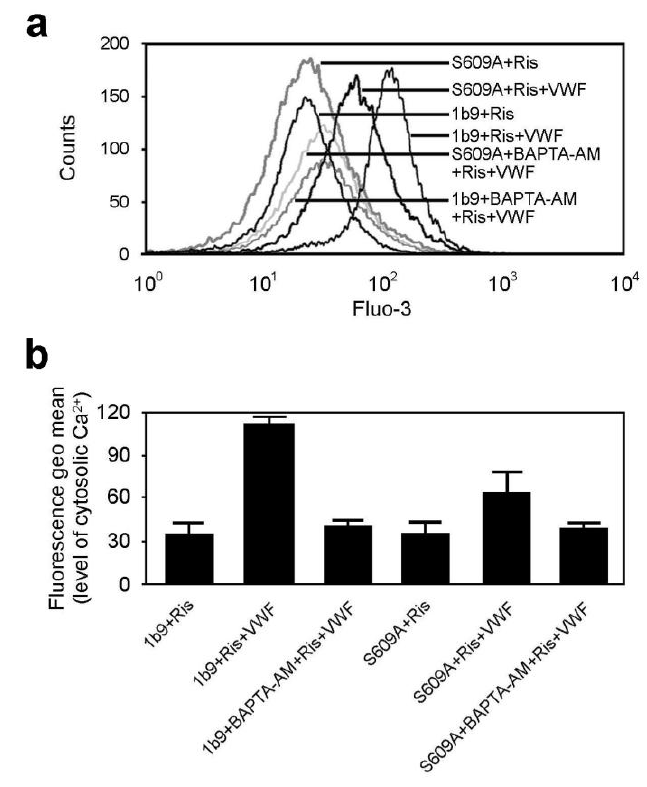
Figure 4. The S609A mutation inhibits elevation of intracellular Ca 2+ . ( a , b ) 1b9 or S609A cells were incubated with 8 μM Fluo-3/AM for 30 min at 37 °C in the dark. The external Ca 2+ was adjusted to 1 mM, and then cells were stimulated by ristocetin in the presence or absence of VWF for 10 min at RT, and analyzed by flow cytometry. The Fluo-3/AM-loaded cells were also pre-treated with BAPTA-AM at 37 °C for 20 min before ristocetin/VWF treatment, and then intracellular Ca 2+ levels were measured by flow cytometry. Representative histograms of Fluo3-fluorescence of cells are shown ( a ). The geometric mean